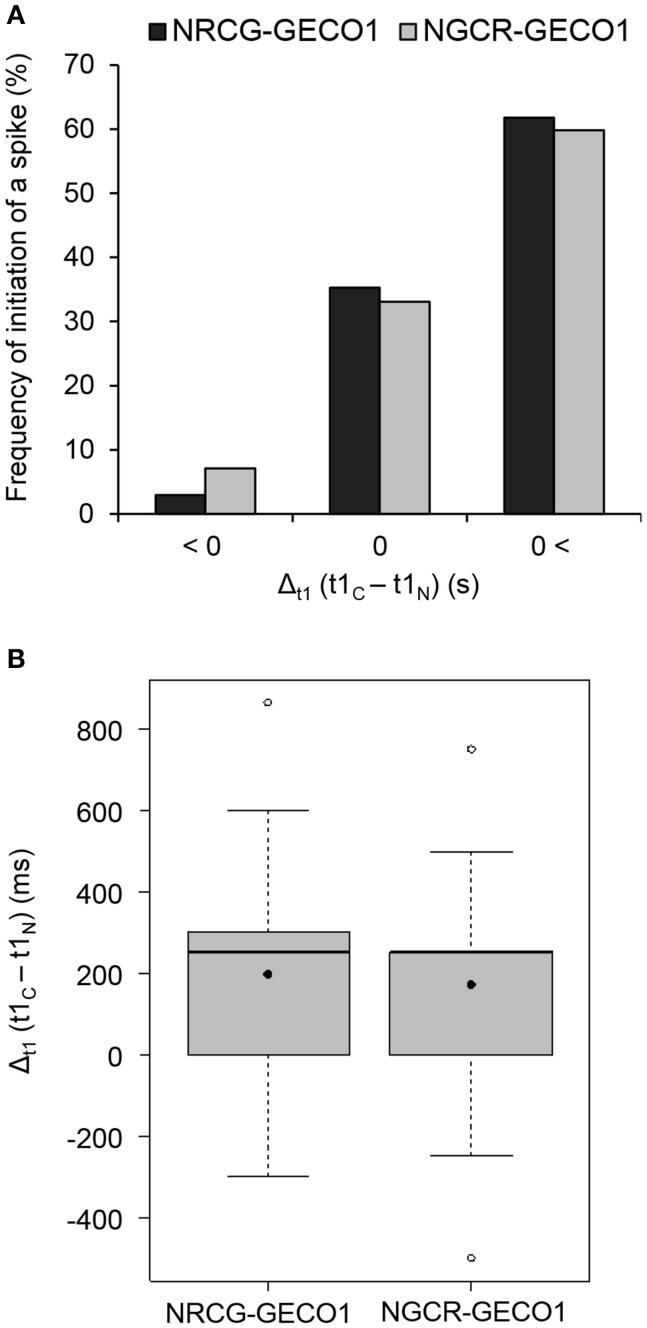
Monitoring NF-elicited Ca2+ signaling with dual GECO sensors reveals a preferential Ca2+ spike start in the nuclear compartment. Time values corresponding to the start of individual spikes (t1, illustrated in Figure 3B) were collected for each sensor and used to calculate the relative delay in the start of a spike. The time interval (Δt1 in s), between peak start measured by sensors, was calculated by subtracting nuclear t1 from cytoplasmic t1-values (t1C-t1N). A Δt1 value below 0 indicates a cytoplasmic-to-nucleus spike start (C → N), a Δt1-value close to 0 indicates coordinated cytoplasmic and nuclear spike start (C = N), and a positive Δt1-value indicates a nucleus-to-cytoplasmic spike start (C←N). These analyses were done with n = 68 (NRCG-GECO1) and n = 127 (NGCR-GECO1) individual spikes from 26 or 24 individual nuclei, respectively. (A) Frequency of the individual spikes showing C → N, C = N, and C←N patterns in the dual NRCG-GECO1 (dark gray) and NGCR-GECO1 (light gray) sensors. No significant differences were found between the sensors (p > 0.05, chi-square test of goodness-of-fit). Frequency distribution within the different categories (C → N, C = N, and C←N), for each dual sensor, is significantly different and not due to a random distribution (1/3 of observations in each category, p < 0.001, chi-square test of goodness-of-fit). (B) Time interval between spike start (Δt1 in ms) measured for each dual sensor. Average/median values for NRCG-GECO1 and NGCR-GECO1 of 197/250 and 174/250 ms, respectively, are not significantly different. Box plots represent first and third quartile (horizontal box sides), minimum and maximum (outside whiskers), median (central lines), and mean (solid black circle).